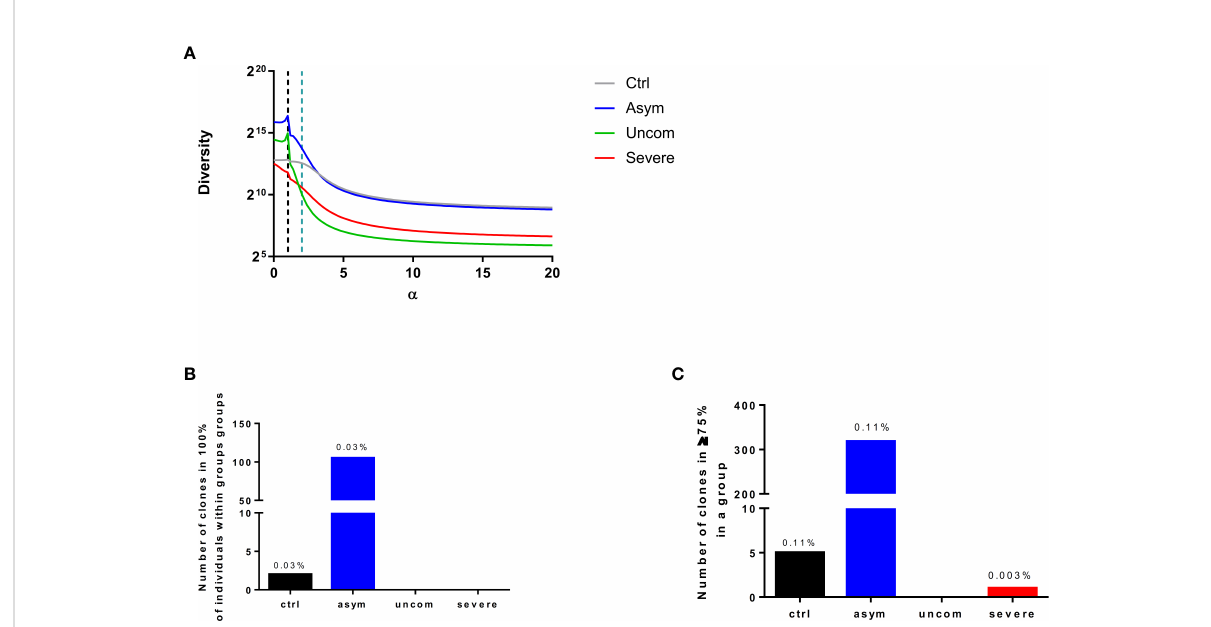
FIGURE 4 TCR diversity and sharing is increased during asymptomatic P. falciparum infection. (A) The diversity of the CDR3 measured using Renyi ’ s entropy. The black dotted lines indicate the Shannon ’ s entropy and the blue dotted lines indicate the Simpson ’ s index of diversity. The graphs show the number of CDR3 sequences shared within (B) 100% (C) at least 75% of individuals in each group.